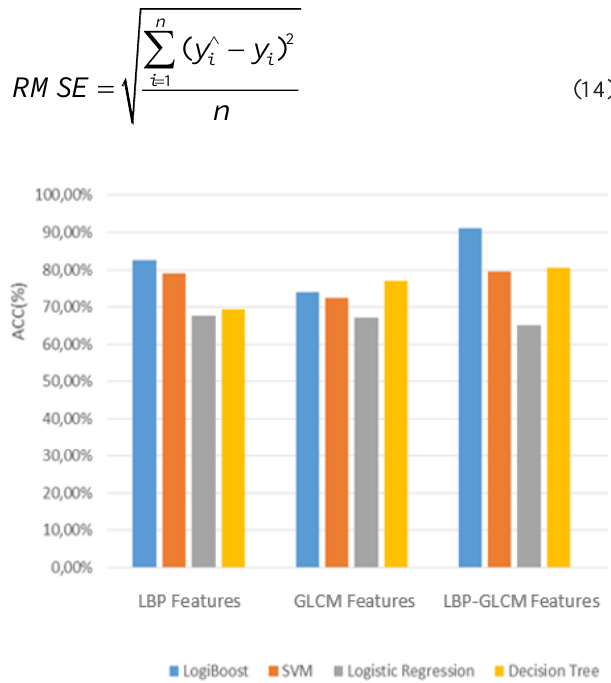
Figure 5. Comparison of classification performance of four different algorithms: LogitBoost, SVM, Logistic regression, and decision